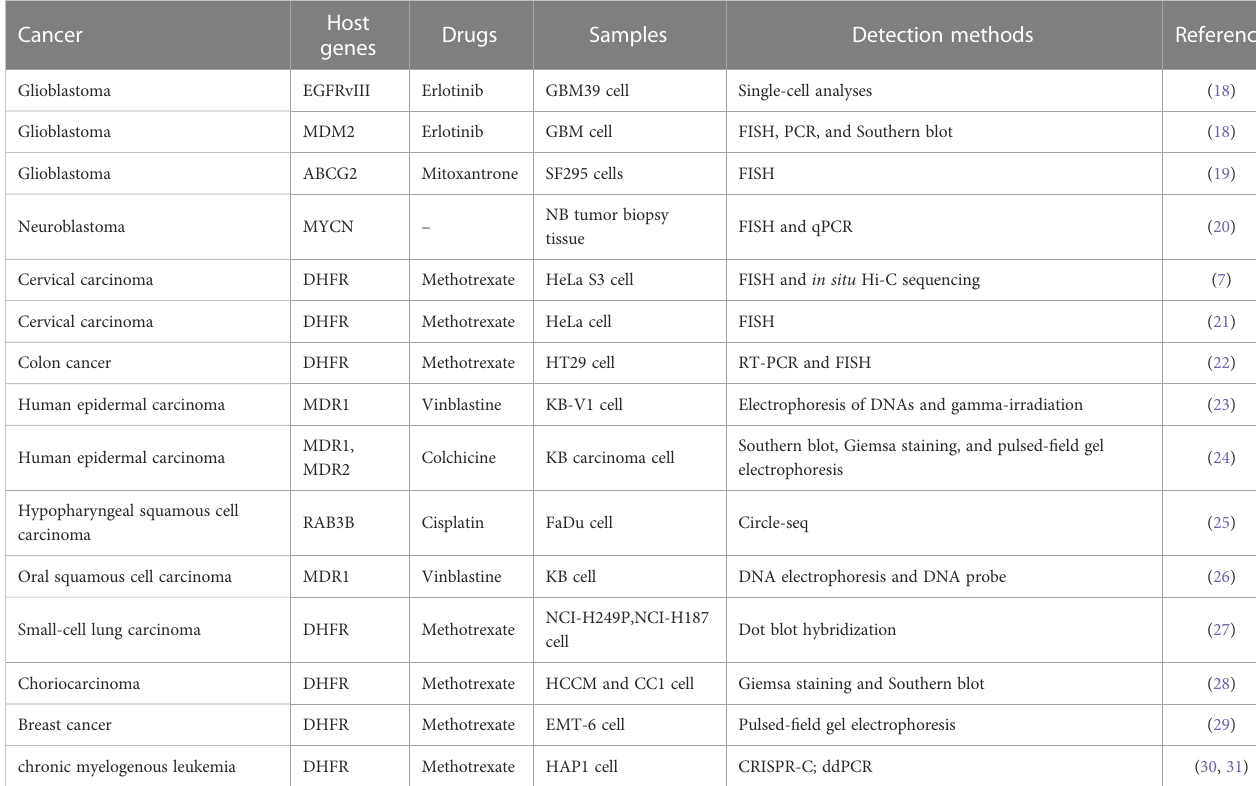
TABLE 1 Summary of eccDNA in chemotherapy drug resistance by cancer types.